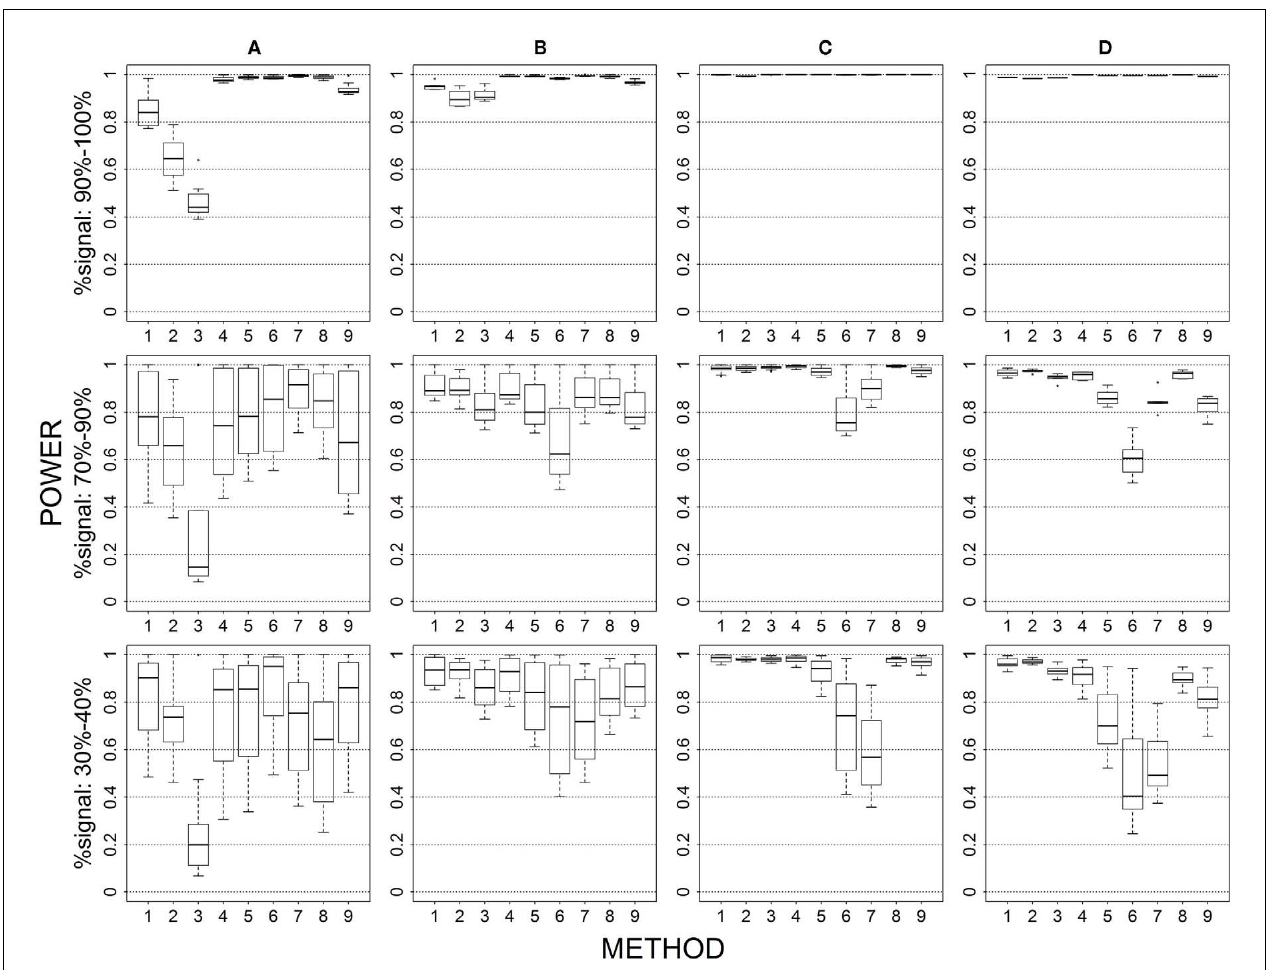
power results for marker-combinations belonging to each average functional allele frequency [ (A) is 0–0.02, (B) is 0.04–0.06, (C) is 0.08–0.11, (D)